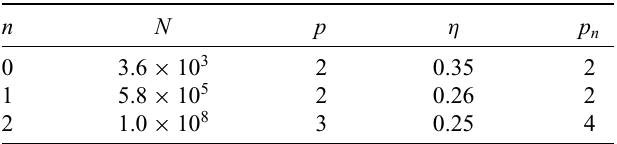
TABLE II. Optimized parameters for target Fock states 0, 1, and 2, for a precision (cid:9) = 0.2 with 95% confidence.